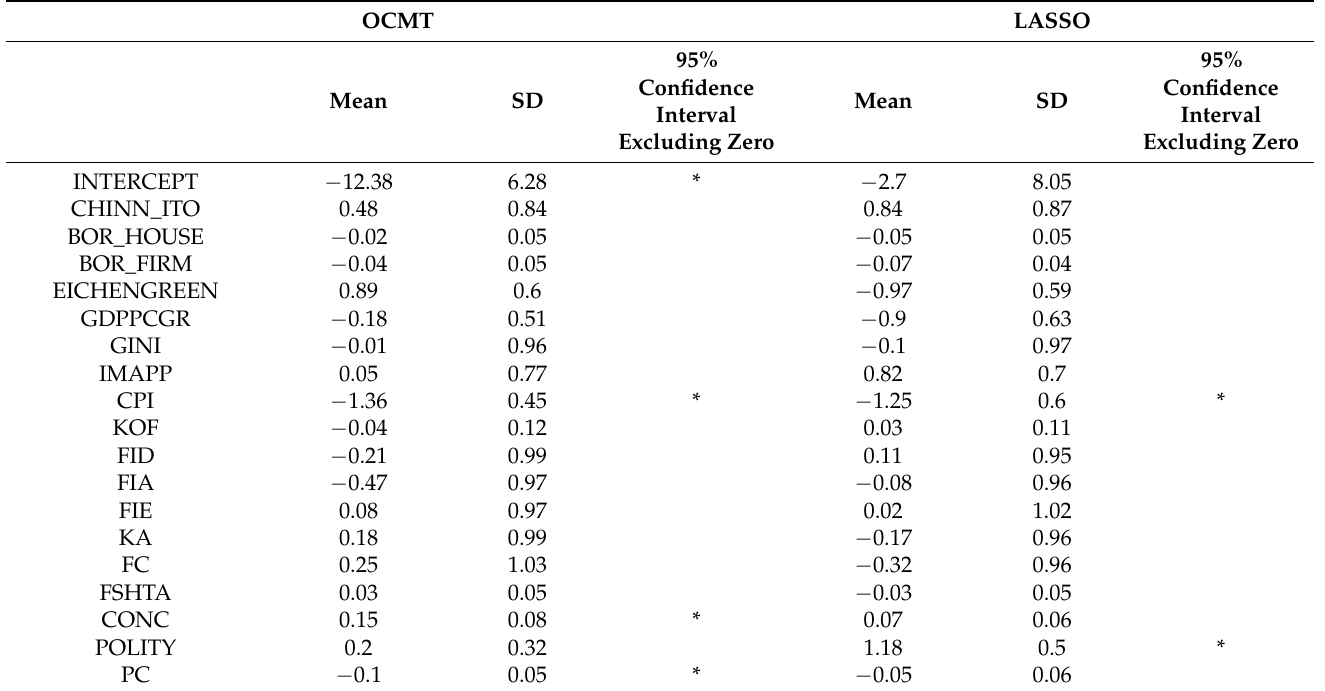
Table 6. Results for the Bayesian logit model for